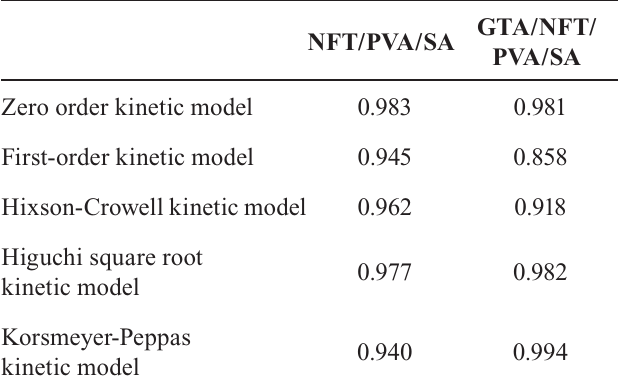
TABLE III - Mathematical models used to explain